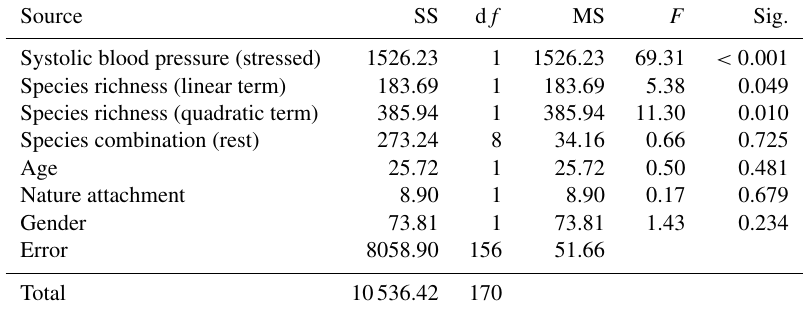
Table 2. Nested analysis of variance of the effects of species richness per array, age, nature attachment, and gender on the mean decrease in systolic blood pressure of participants during the relaxation phase after a stress